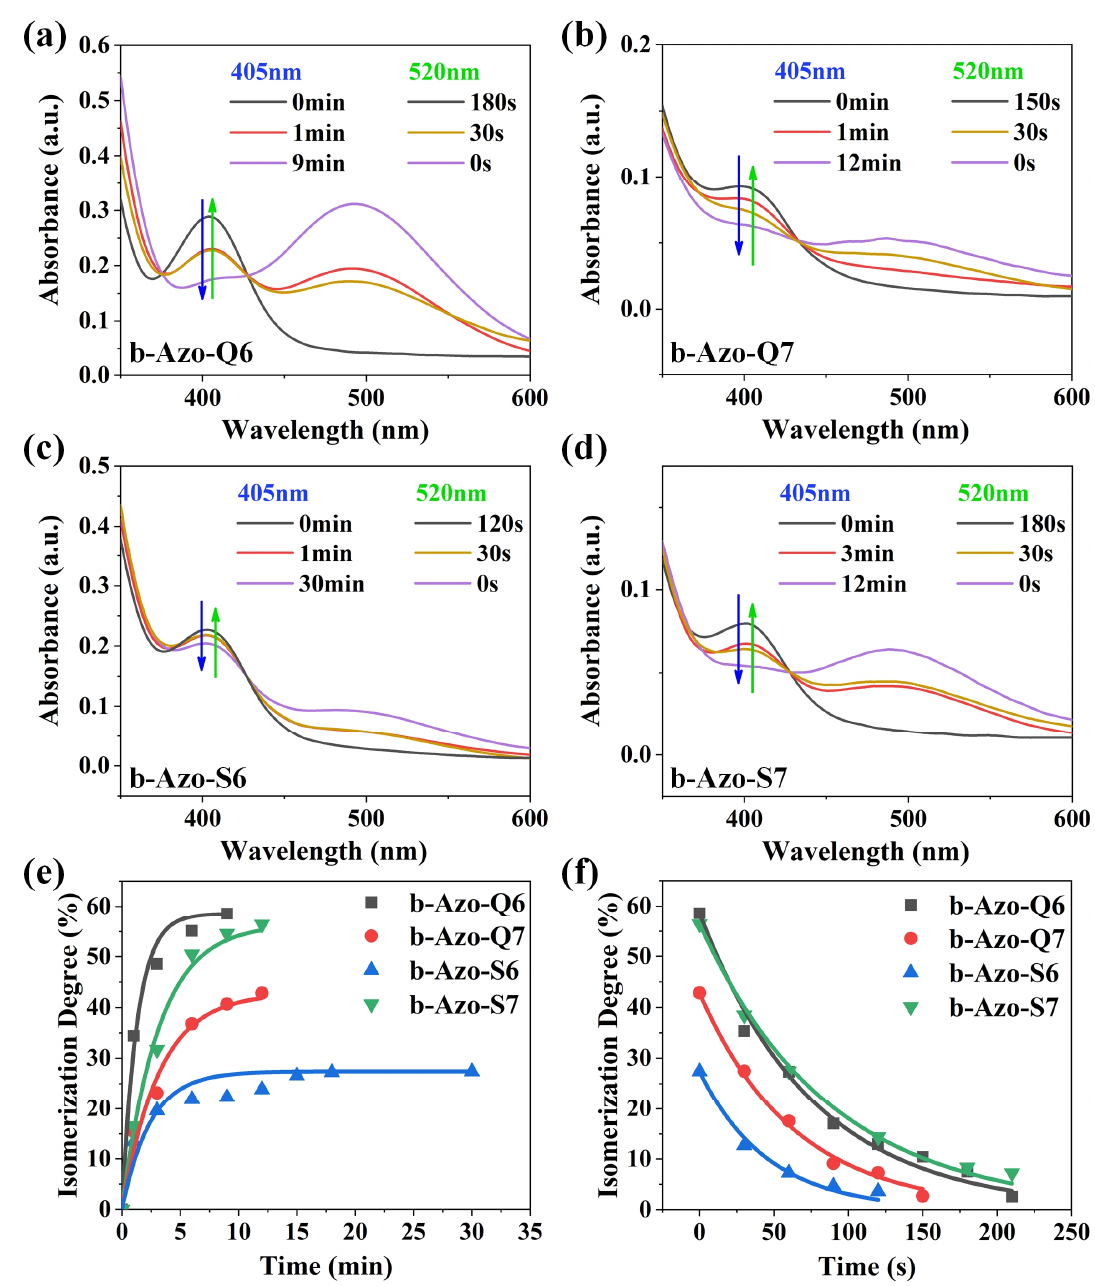
Figure 2. ( a – d ) UV–vis absorption spectra of the four b-Azo chromophores in the liquid state. Samples were taken in the neat state and dissolved in EtOAc, and the spectra had been normalized with respect to the isosbestic point at 427.5 nm. ( e ) Degrees of isomerization of the four b-Azo chromophores during charging versus time under 405 nm of blue light irradiation. ( f ) Degrees of isomerization of the four b-Azo chromophores during reversion versus time under 520 nm of green light